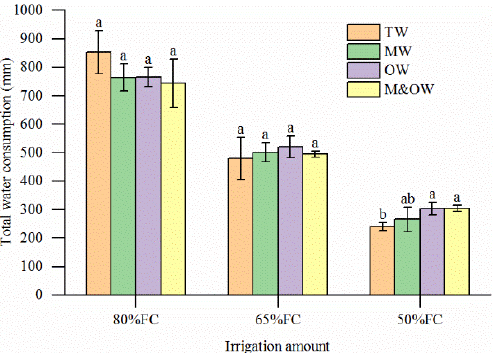
Figure 9. Effect of tap water (TW), magnetized water (MW), oxygenated water (OW), and magnetized and oxygenated water (M&OW) irrigation on total water consumption with 80%FC, 65%FC, and 50%FC irrigation amount. Different letters above the bars indicate significant differences among treatments at p < 0.05. The error bars indicate standard deviations.